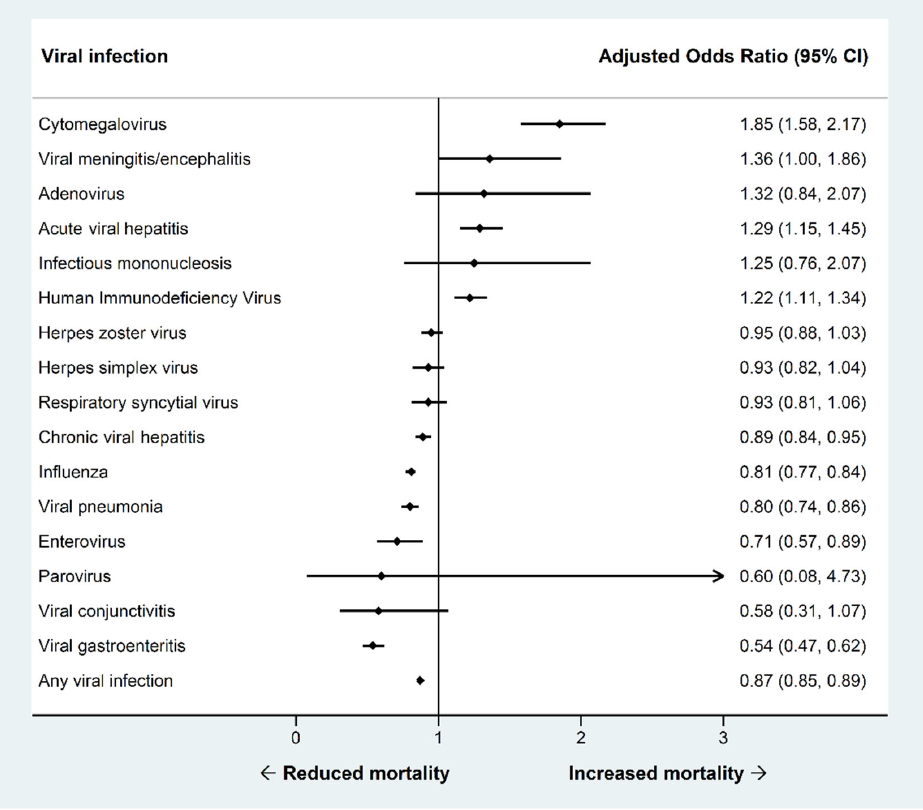
Figure 3. Adjusted odds of in ‐ hospital mortality for records with a diagnosis of viral infection com ‐ pared to those without a diagnosis of viral infection in patients admitted with heart failure.